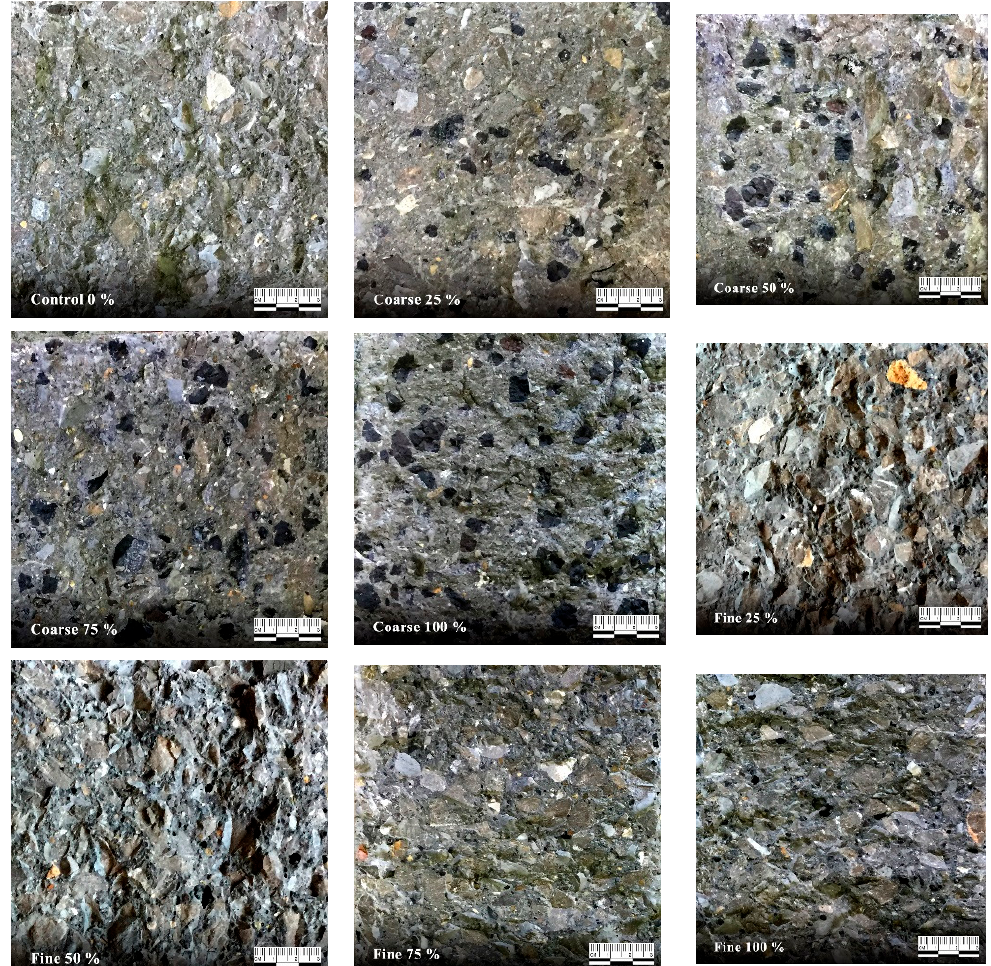
Figure 10. Detail of specimens with different percentages of coarse and fine EAFS aggregates . Figure 11. Detail of specimens with different percentages of coarse and fine EAFS